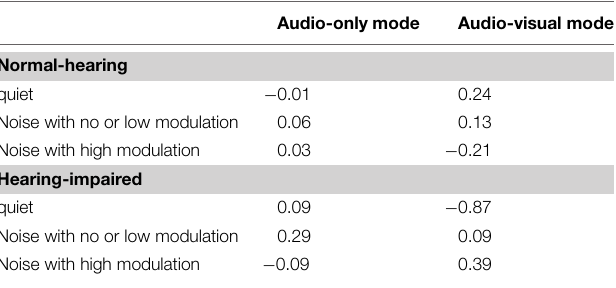
TABLE 2 | The difference in CSC scores obtained for the English and Swedish samples (English – Swedish) on comparable test conditions with an updating task presented under high memory